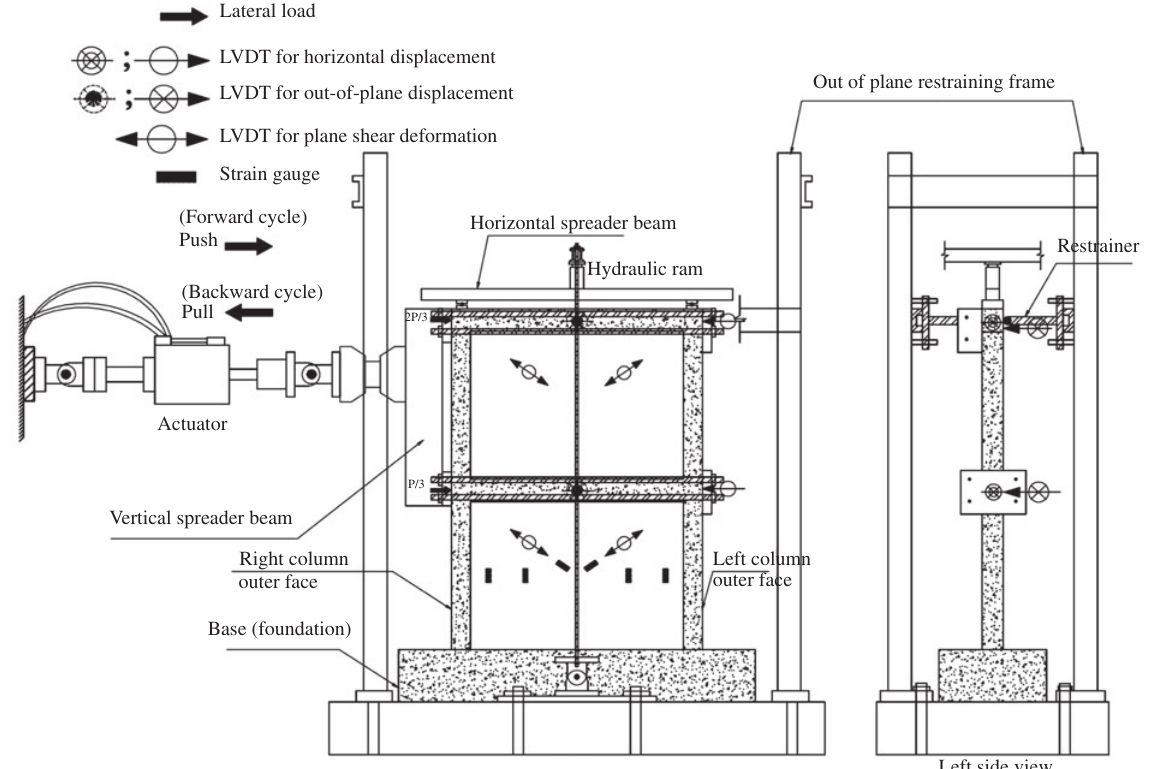
Figure 6 Test set-up and instrumentation. cycle (cycle 6) were -44.4 kN and -0.06 % , respectively. The fi rst separation between the second storey panel and the fi rst storey beam occurred at the 10 th cycle. The pull load in this cycle was -81.0 kN (-0.19 % drift), which was very close to the maximum pull load. The maximum loads for the forward and backward half cycles that the specimen could carry, were 83.7 kN (0.59 % drift) and -86.2 kN (-0.38 % drift), respectively. The base shear-roof drift diagram is shown in Figure 12 . The failure is attributed to the formation of lap splice fail- ure of column longitudinal bars, along with the axial tension failure of the vertical FRP strips, as shown in Figure 13 .